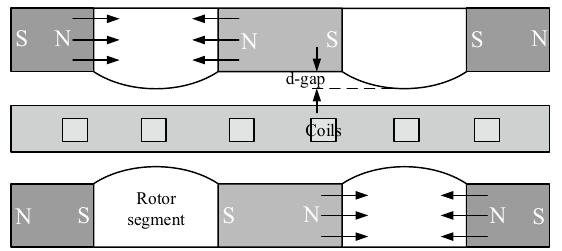
Figure 17 Structure of an